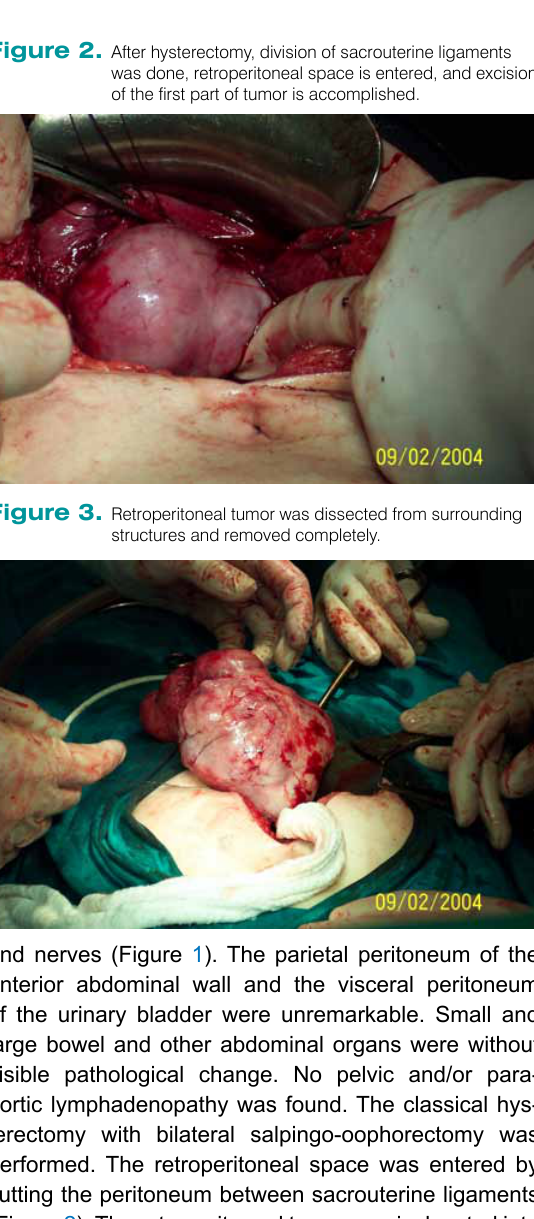
Figure 1. Closer view on sacrouterine ligaments and upper part of tumor.